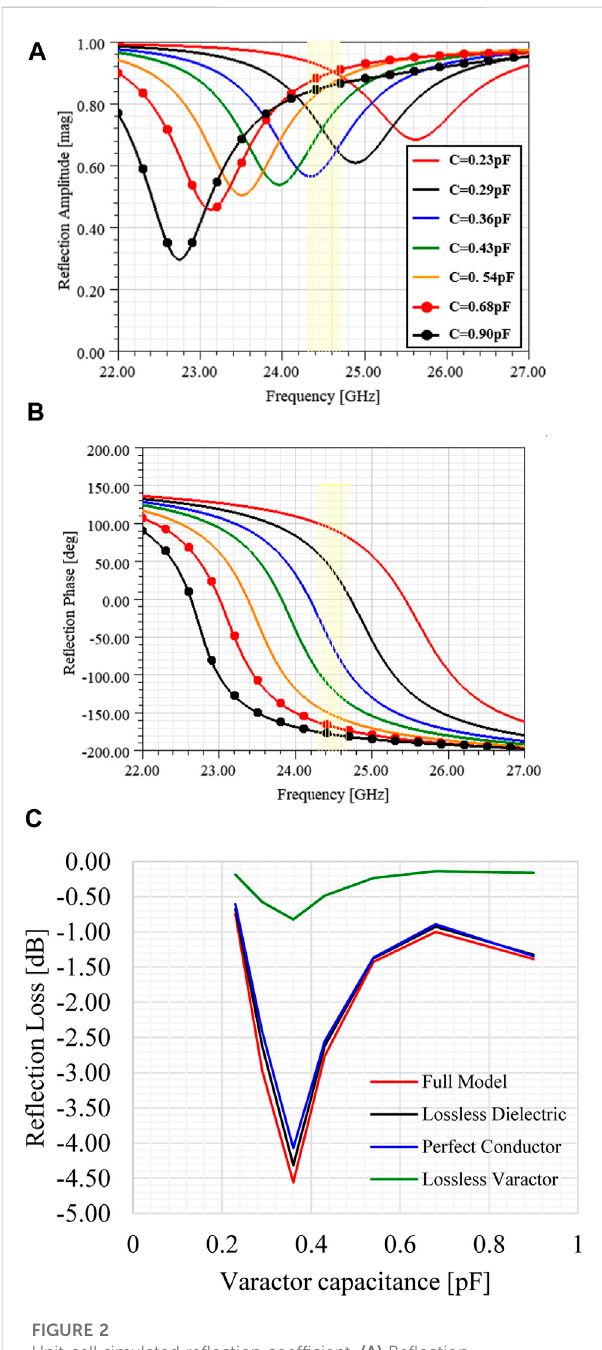
FIGURE 2 Unit cell simulated re fl ection coef fi cient. (A) Re fl